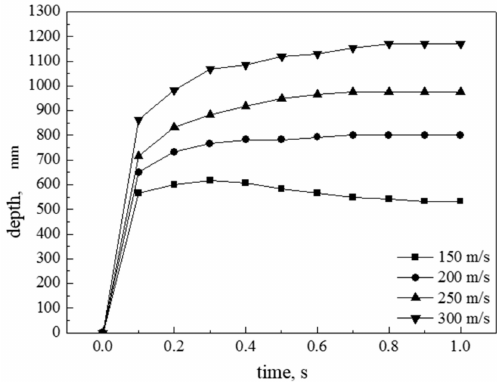
Figure 7. Variation of raceway depth with time at di ff erent blowing velocities.